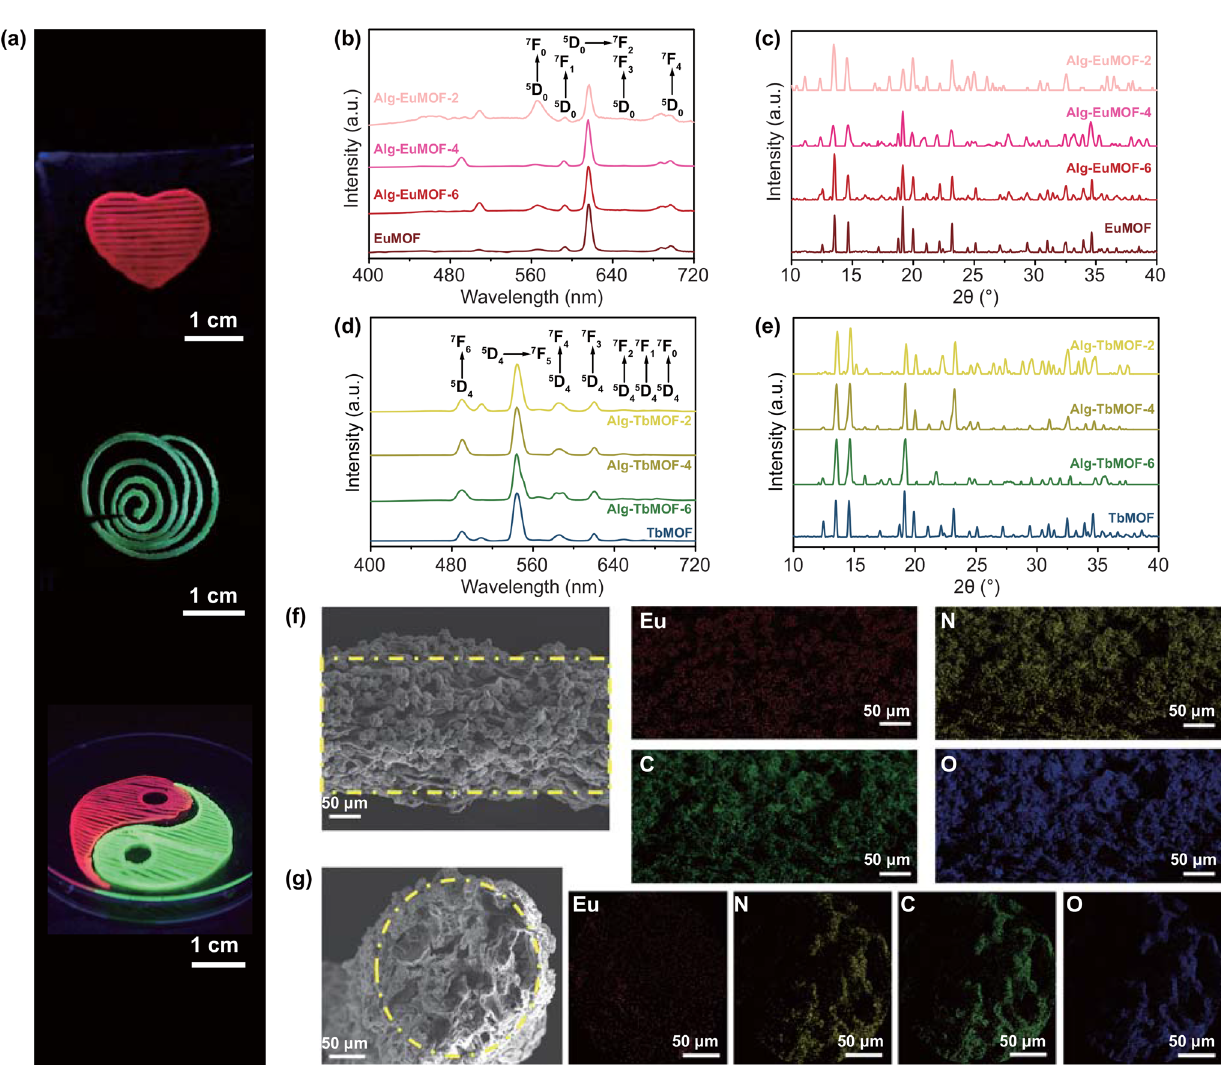
Fig. 3 Post-printing treatment of 3D-printed constructs in the individual lanthanide ion solution. a Photographs of several 3D patterns under UV light irradiation ( λ exc = 254 nm). b, c Fluorescence emission spectra and XRD patterns of Alg-EuMOF with different mellitic acid additions. d , e Fluorescence emission spectra and XRD patterns of Alg-TbMOF with different mellitic acid additions. f Side SEM image and g section SEM image of Alg-EuMOF-4 and the corresponding energy dispersive spectrometer (EDS) mapping of Eu, N, C, and O